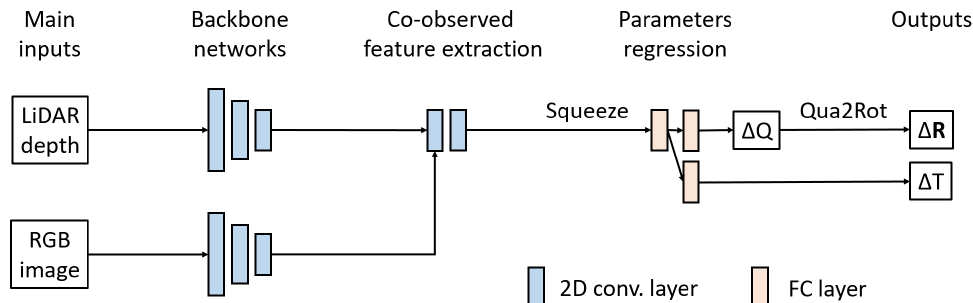
Figure 1. The general pipeline of deep learning based extrinsic calibration method. Inputs are D 0 and R . D 0 are obtained by projecting P l into the image plane with K , R 0 , and T 0 . Outputs are ∆ R and ∆ T . Squeeze is the operation to convert the 2D feature map into a 1D feature vector. Function Qua2Rot converts the quaternion ∆ Q as the rotation matrix ∆ R . Conv. and FC mean convolution and fully connected, respectively.